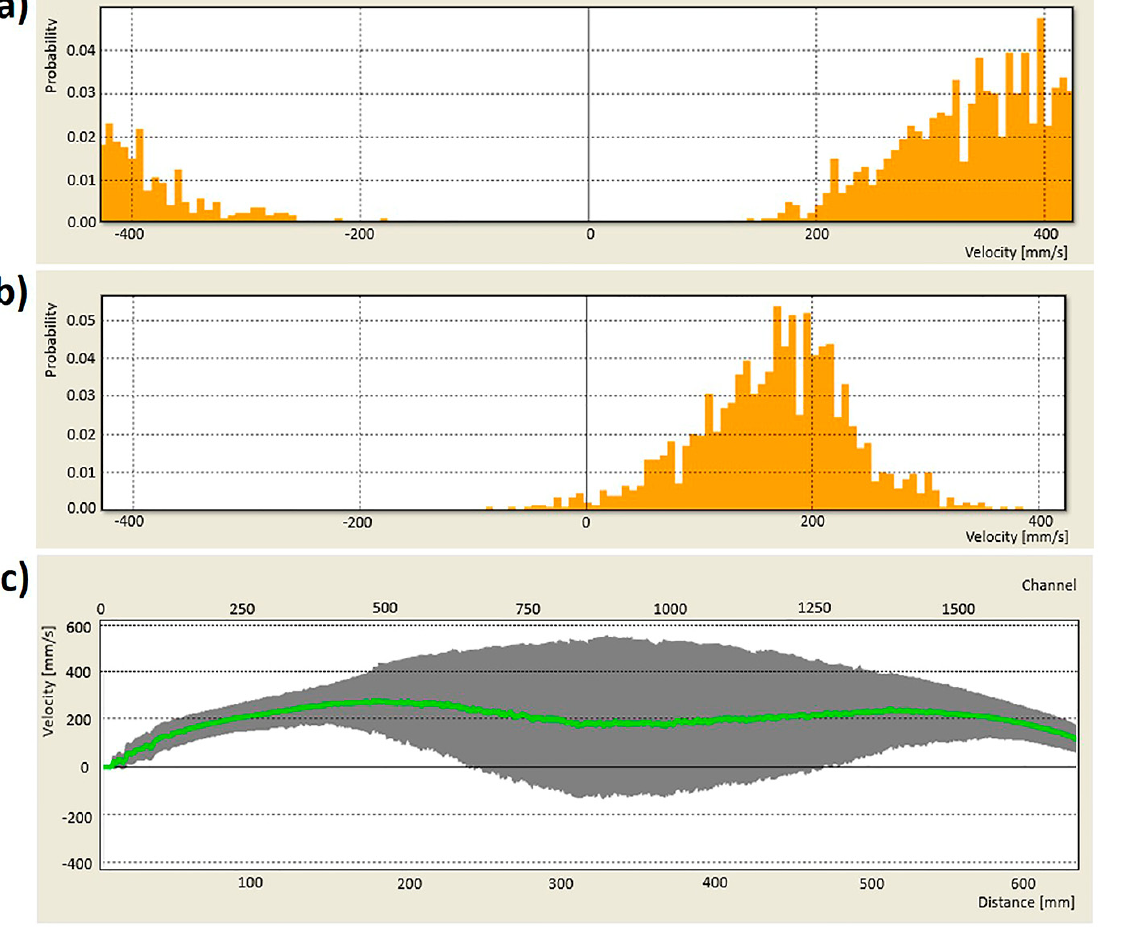
Figure 7. Turbulence features. ( a ) PDF of velocity in point L33. ( b ) PDF of velocity in point L60. ( c ) measured velocity profile along the line located 20 mm below the meniscus.